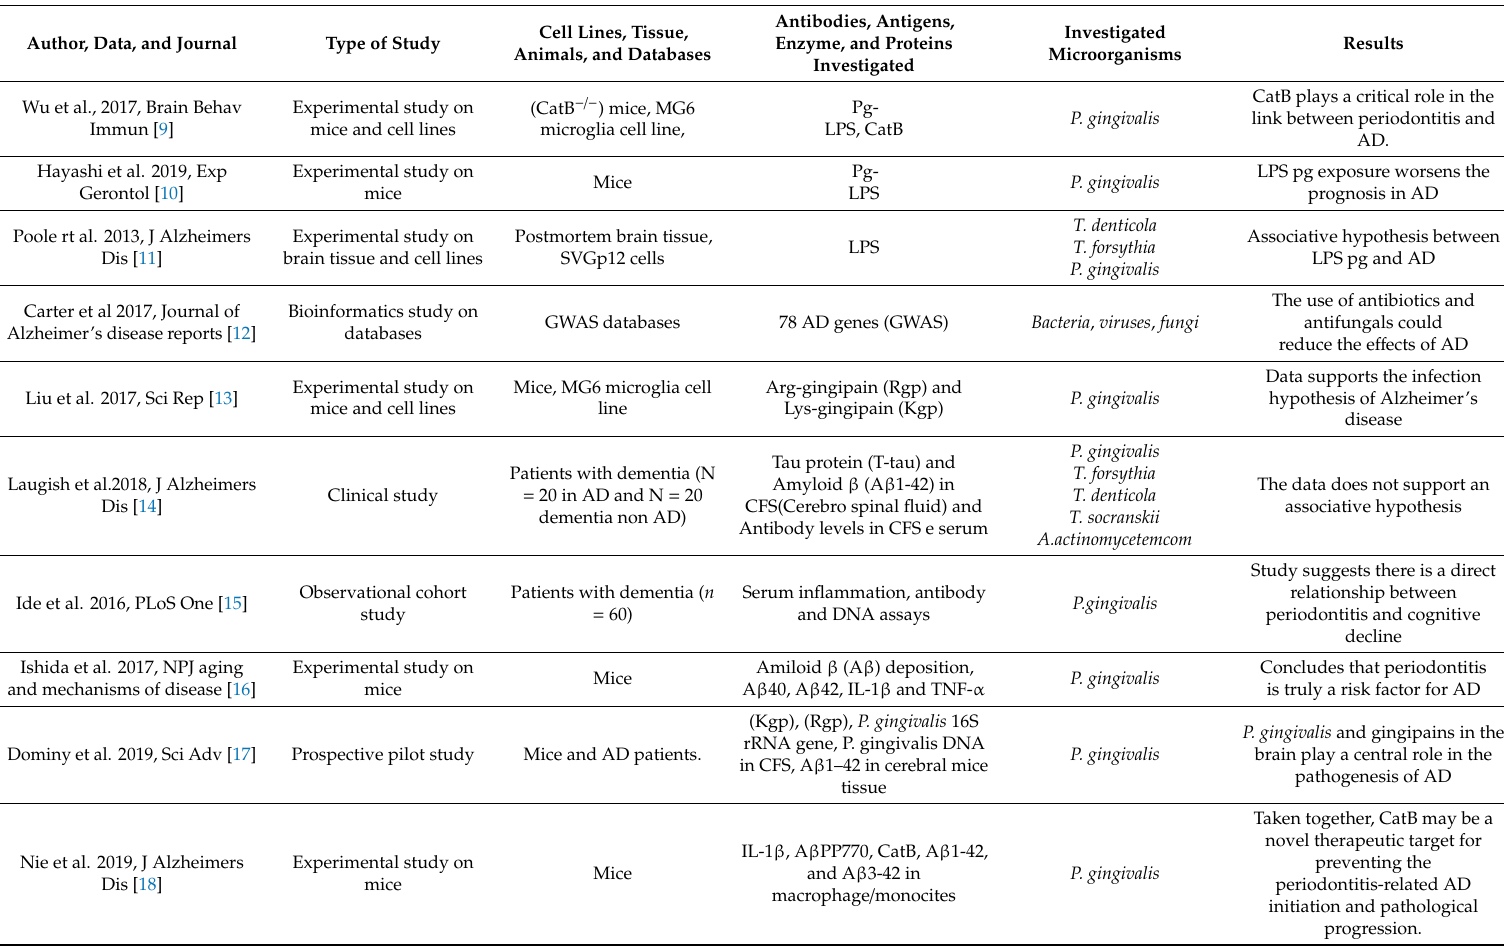
Table 3. Extracted data for secondary